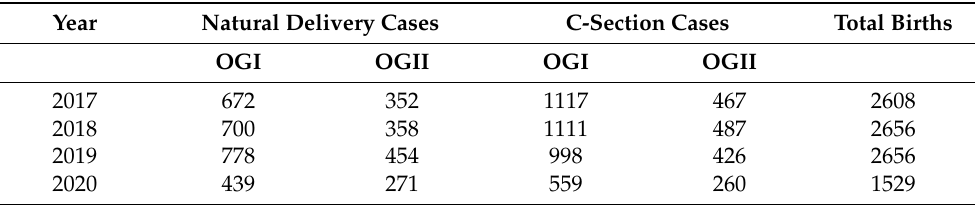
Table 1. Distribution of cases in “Bega” Maternity Hospital by type of birth.